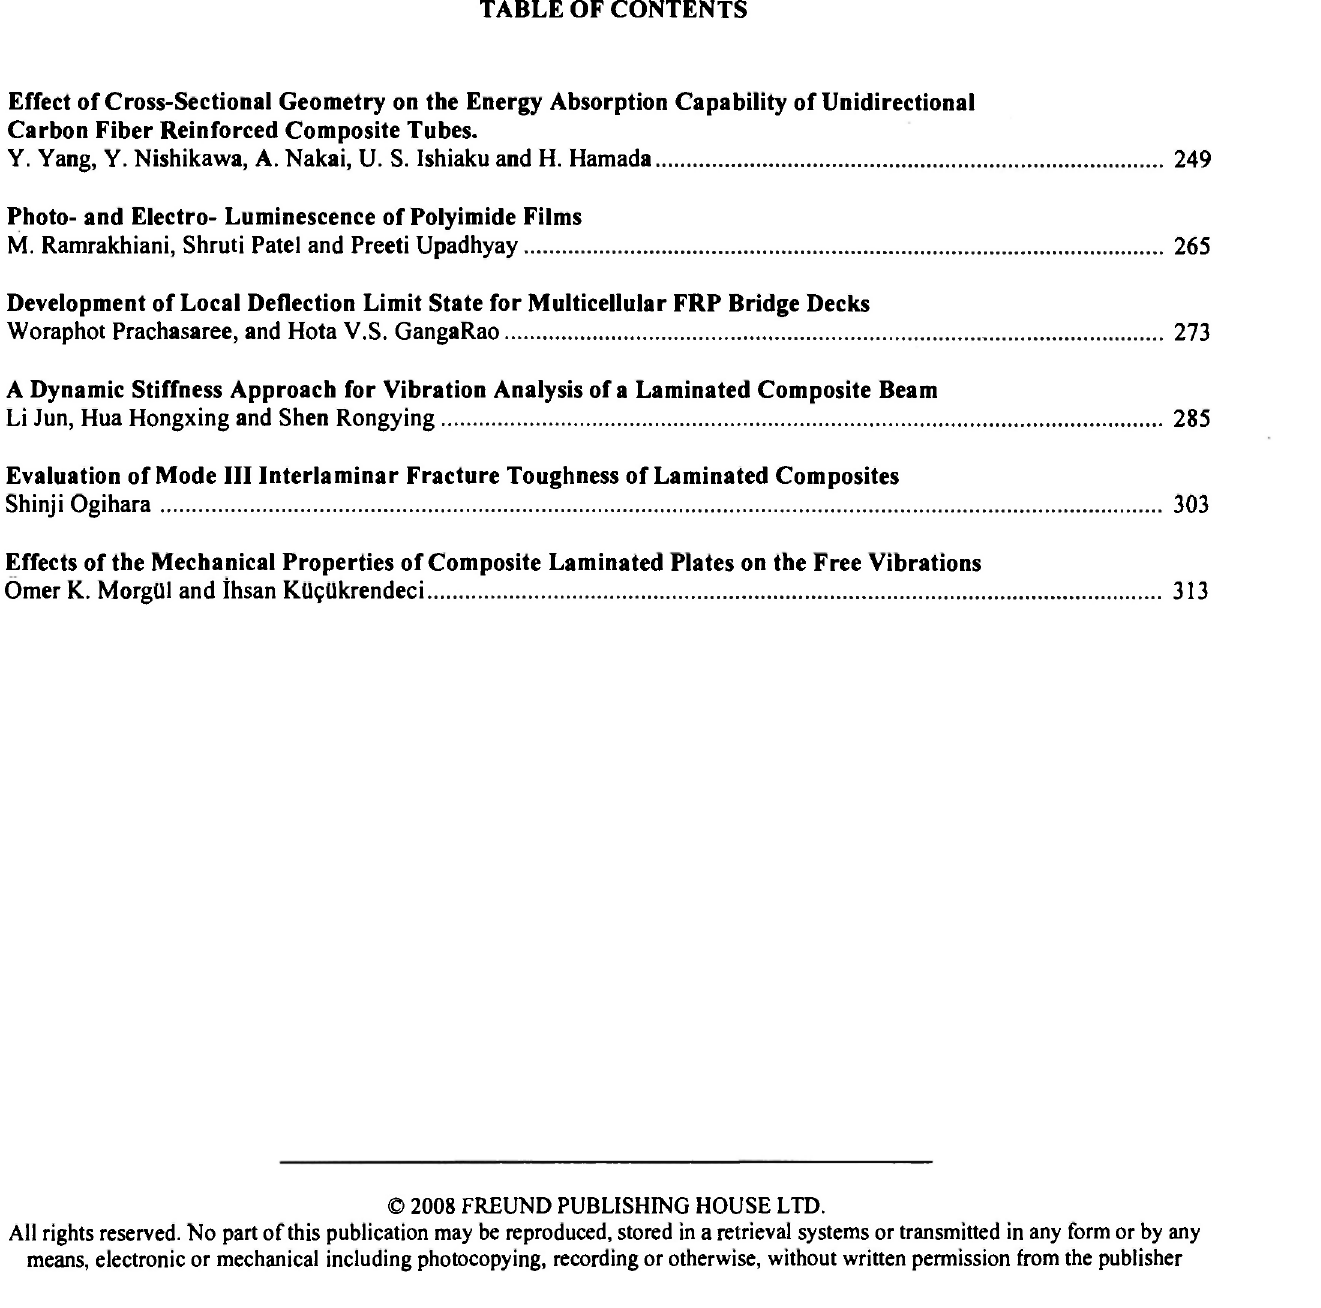
Effect of Cross-Sectional Geometry on the Energy Absorption Capability of Unidirectional Carbon Fiber Reinforced Composite